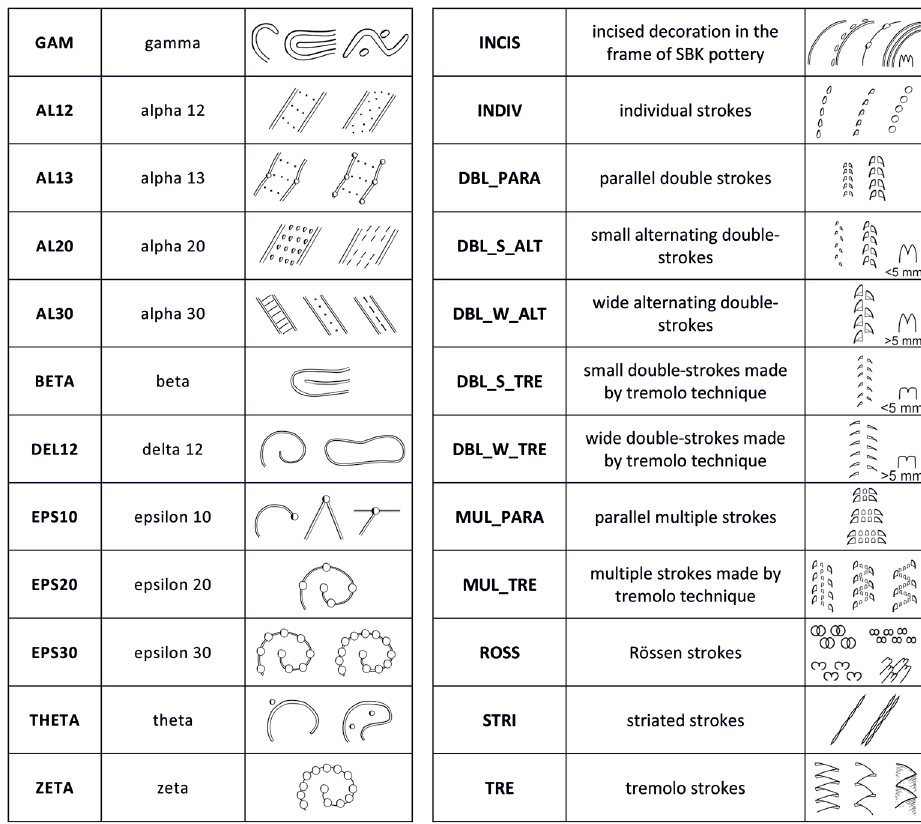
Figure 2. Linear and stroked pottery decoration styles recorded at